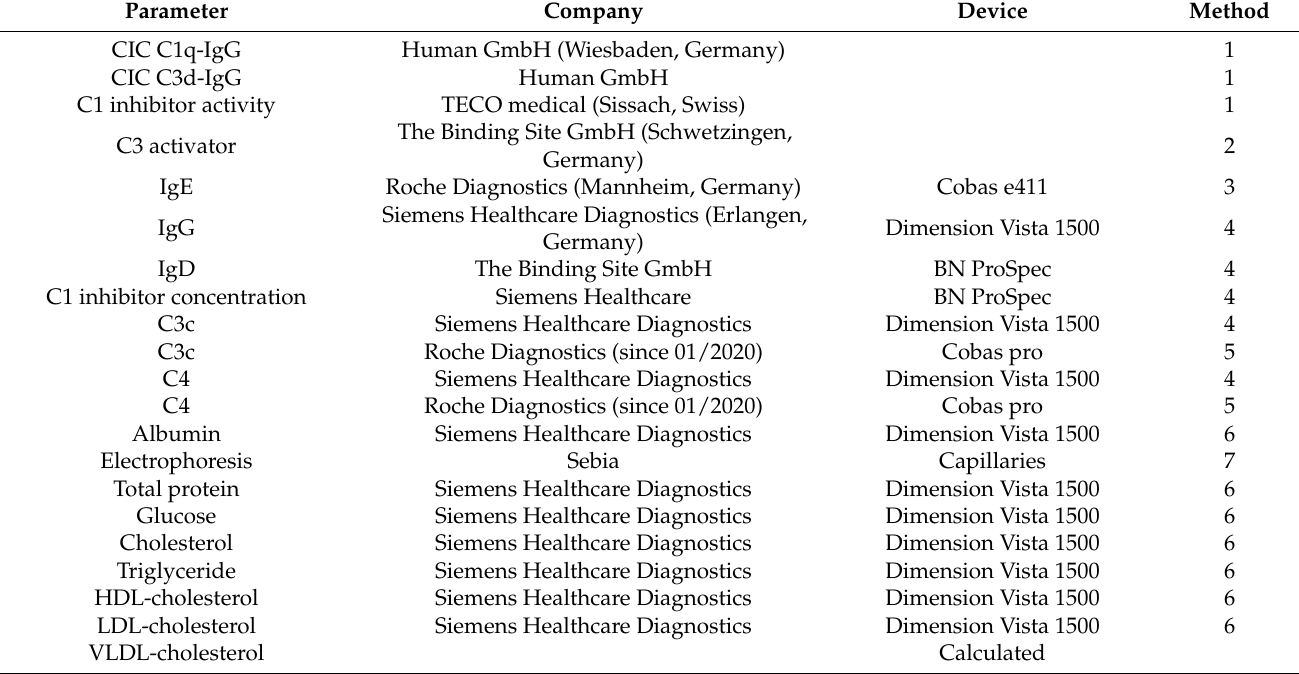
Table 3. Tests, equipment, and methods used for determination of heat-induced